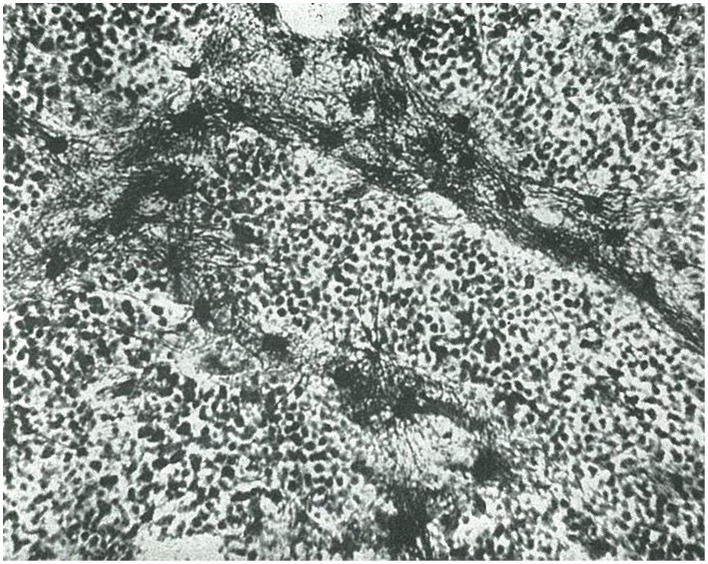
Examples of oligodendrocytoma (taken from Río-Hortega, 1933a).